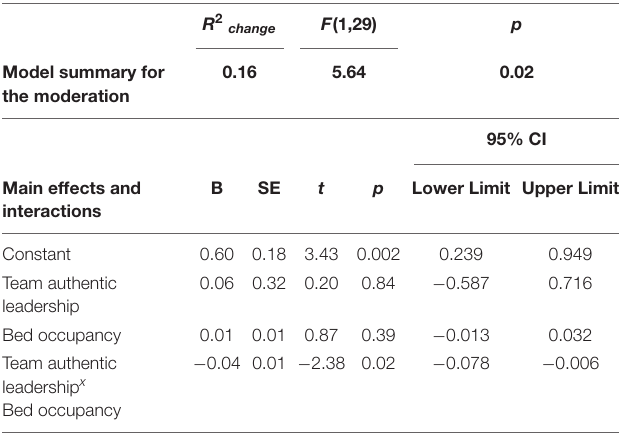
N = 33 teams. Team authentic leadership and occupied beds were mean centered prior to analysis. Data analysis was performed using 5000 bootstrap samples with a 95% CI. The “x” stands for the